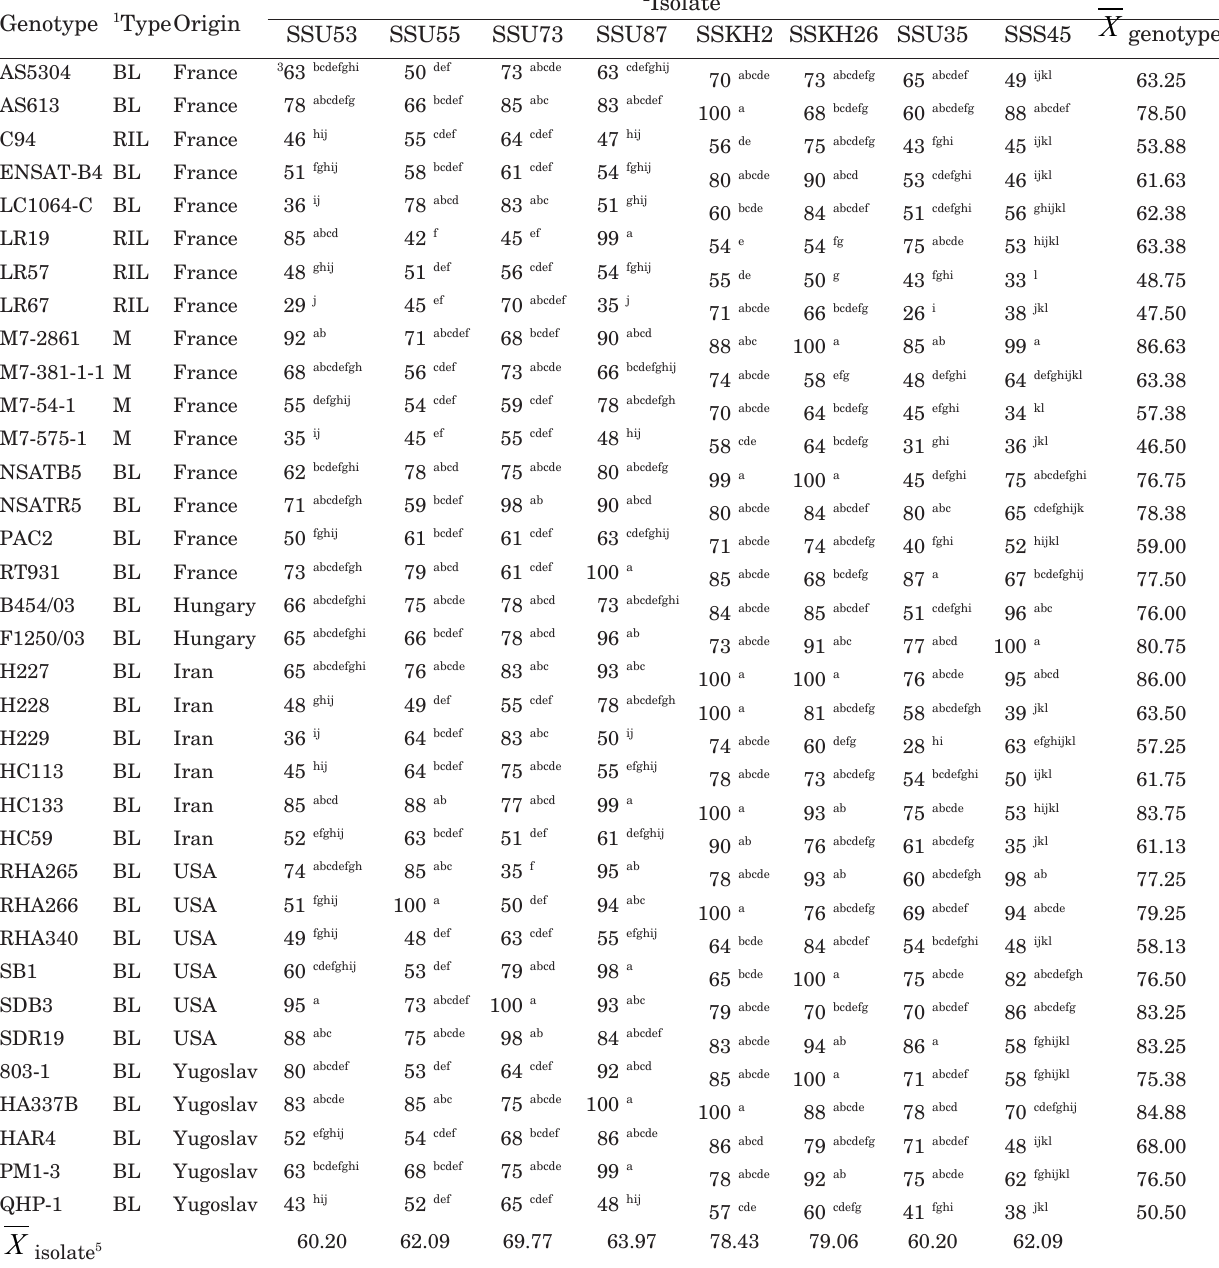
Table 2. Mean percent necrotic area on 1 cm of the stem bases of 35 sunflower genotypes inoculated with eight Scle- rotinia sclerotiorum isolates (SSU53, SSU55, SSU73, SSU87; SSKH2, SSKH26, SSU35, SSS45) under controlled conditions. Percentage of necrotic area was measured visually 3 days after